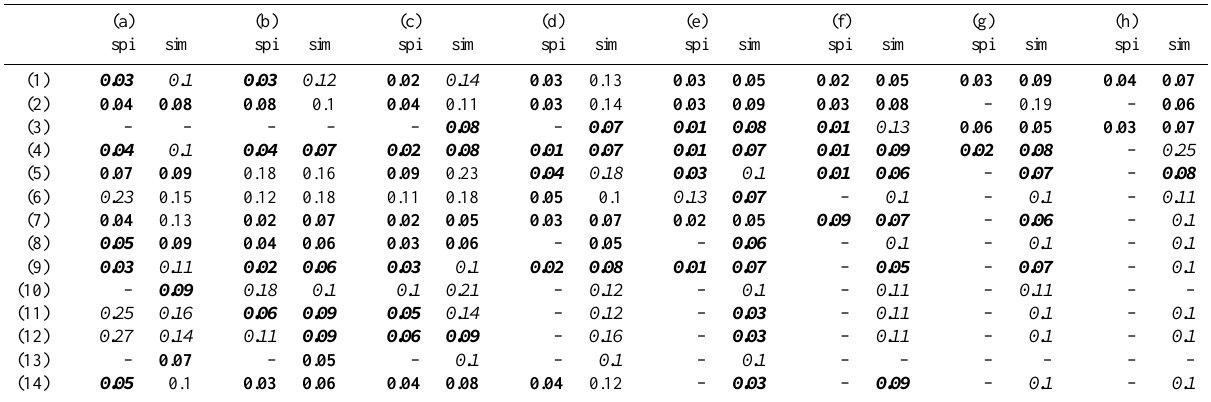
Table D6. Root mean square error (RMSE) between LPJ-GUESS using 400 replicate patches and LPJ-GUESS with GAPPARD for stands a to h. All values were calculated with a temporal resolution of 10yr. spi: RMSE for simulation spinup time (800yr); sim: RMSE for simulation years 1900–2100; yr: only actual year difference considered; p: period of 50yr considered. Numbers in italics indicate that in both models less than 0.5kgCm 2 of that species were produced at any one point during the simulation. Bold numbers indicate values less than